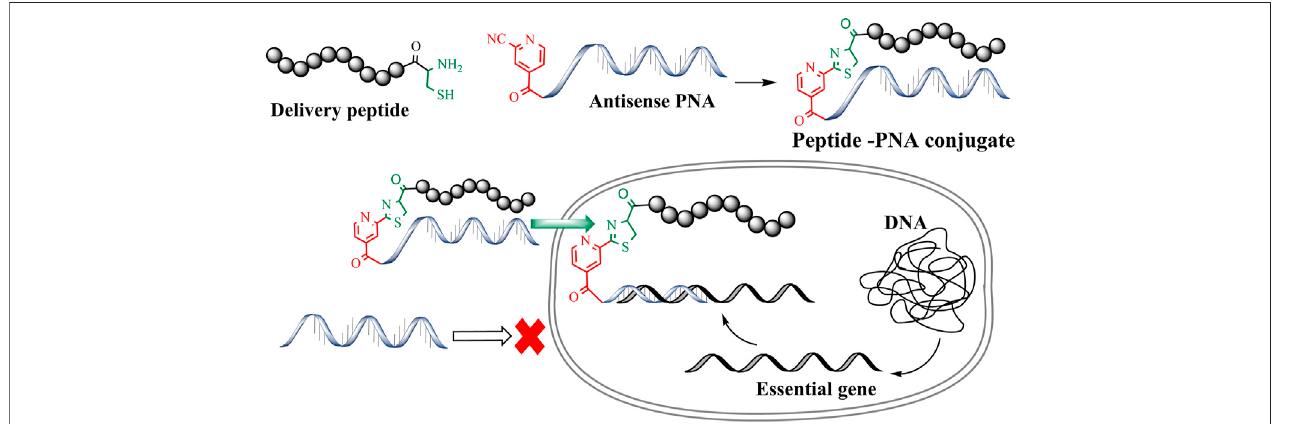
FIGURE 1 | CINA mediated conjugation to generate peptide-PNA antisense